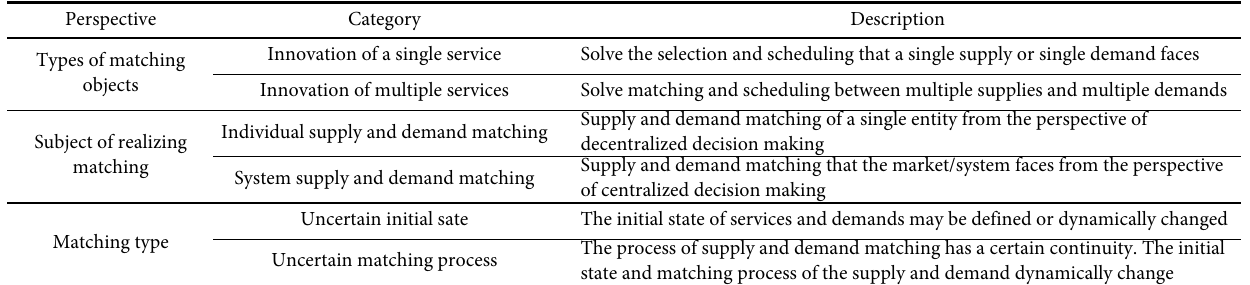
Table 2 Classification of the correlation relationship between demand emergence and service